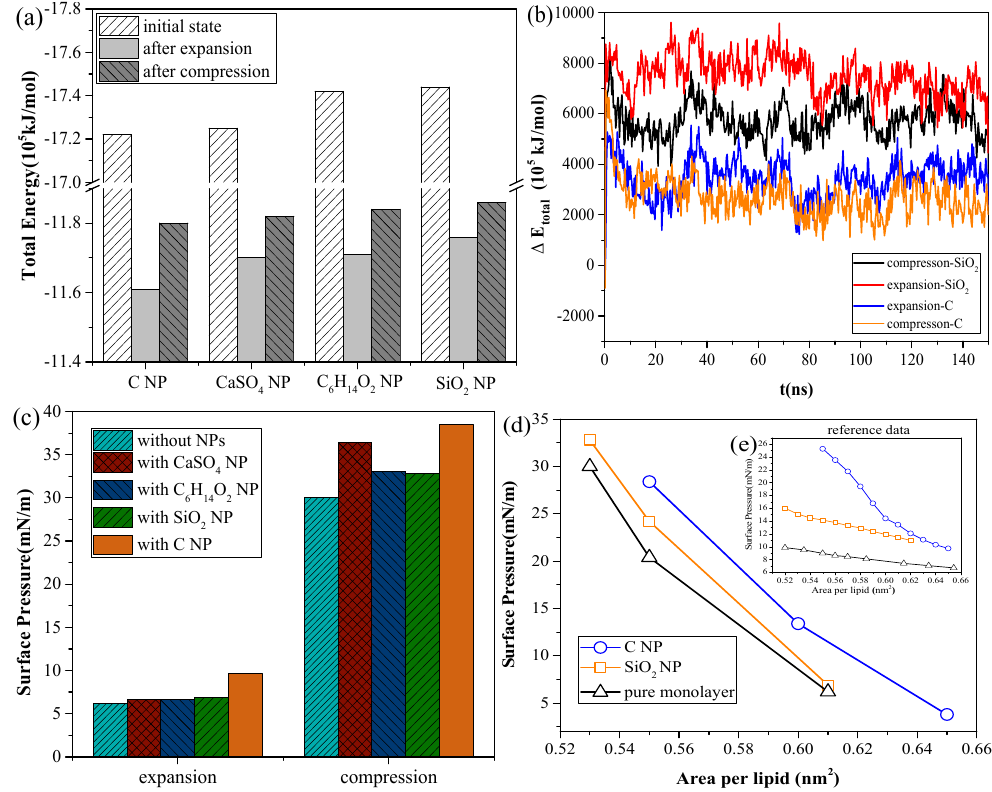
Figure 3. Analyses of system energy and surface pressure for the systems containing a pure monolayer or an NP monolayer: ( a ) total energy of different systems after interaction, ( b ) Δ E total (i.e., the difference in total energy between the NP monolayer system and the pure monolayer system), ( c ) surface pressure of the monolayer in exhalation and inhalation breathing states, and ( d ) surface pressure–area isotherms of the monolayers from the simulation and Ref. [25].